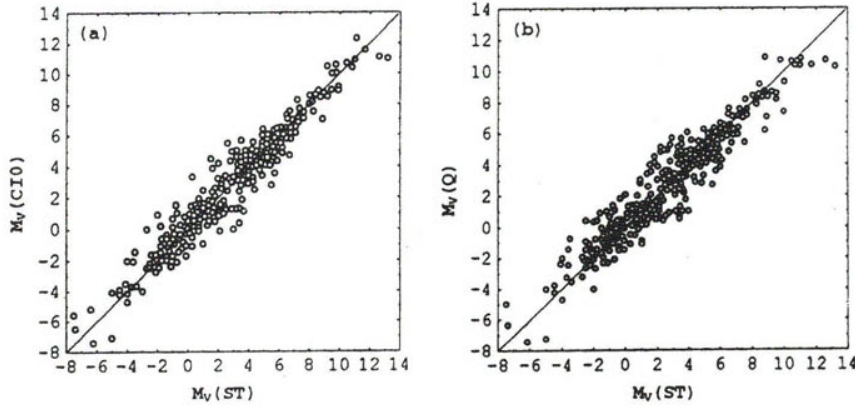
Fig. 4. Comparison of the standard values of M v with those derived by the method of comparison of intrinsic color indices (a) and Q-parameters